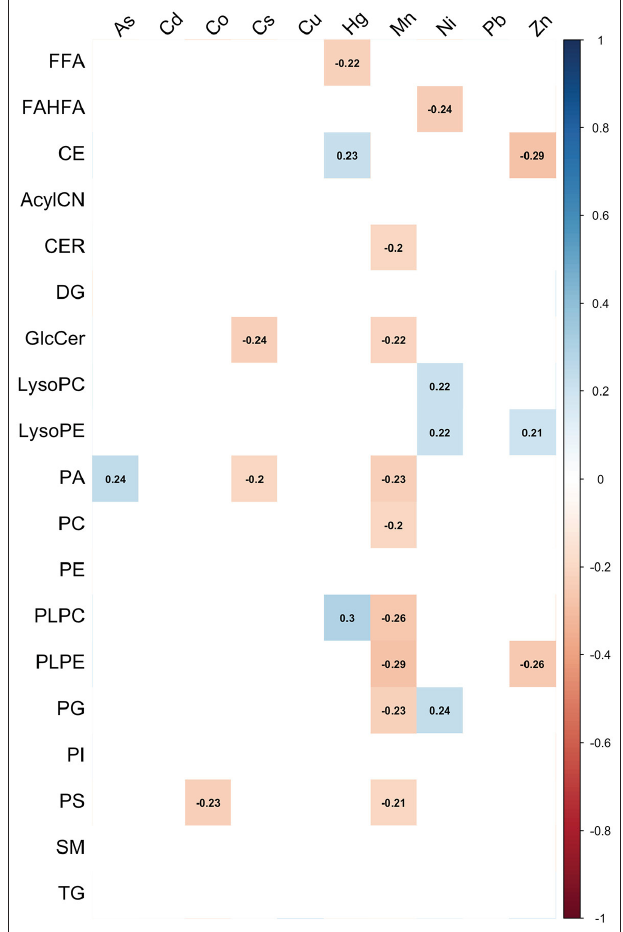
FIGURE 3 | Correlation matrix between maternal metal/metalloid blood concentrations and lipid